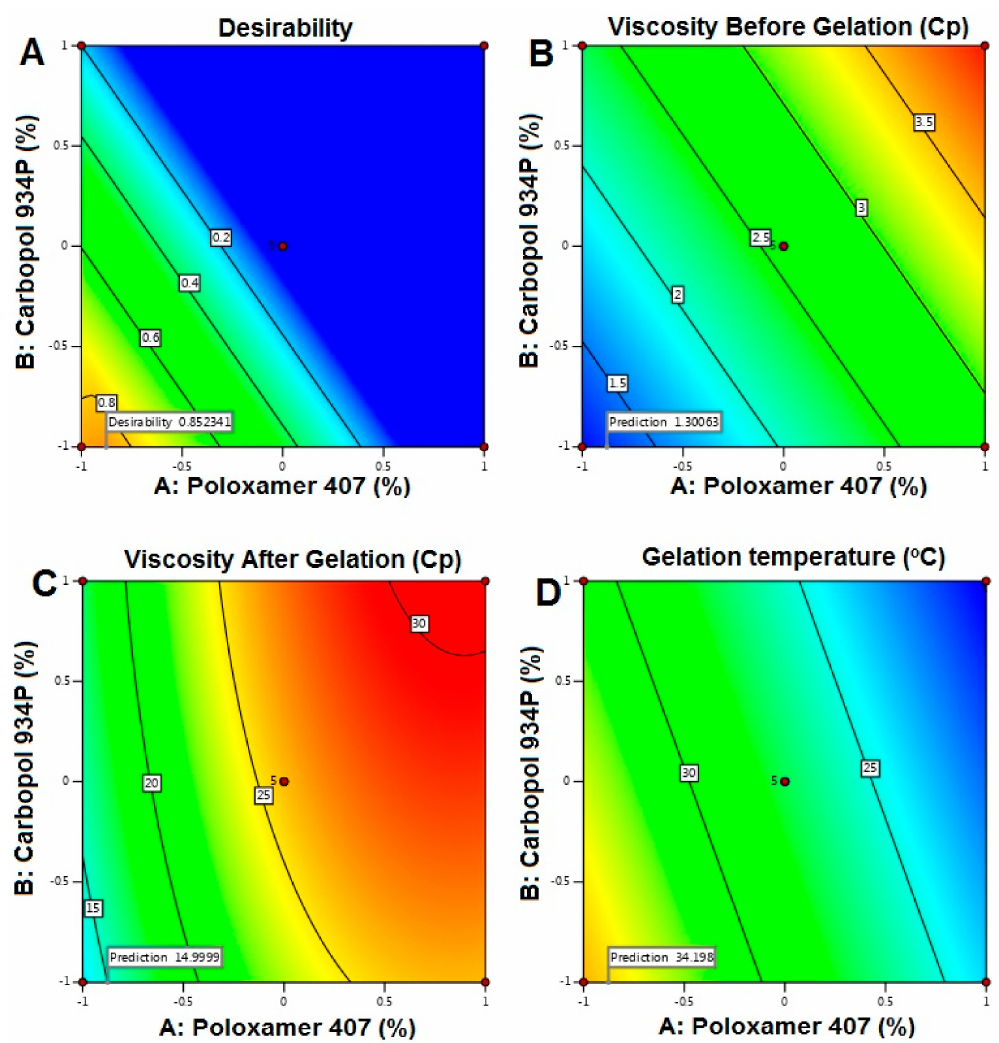
Figure 6. Contour plots representing the e ff ect of studied variables on selected responses and desirability. ( A ). Contour plot representing the e ff ect of studied variables on desirability; ( B ). Contour plot representing the e ff ect of studied variables on viscosity before gelation; ( C ). Contour plot representing the e ff ect of studied variables on viscosity after gelation; ( D ). Contour plot representing the e ff ect of studied variables on gelation